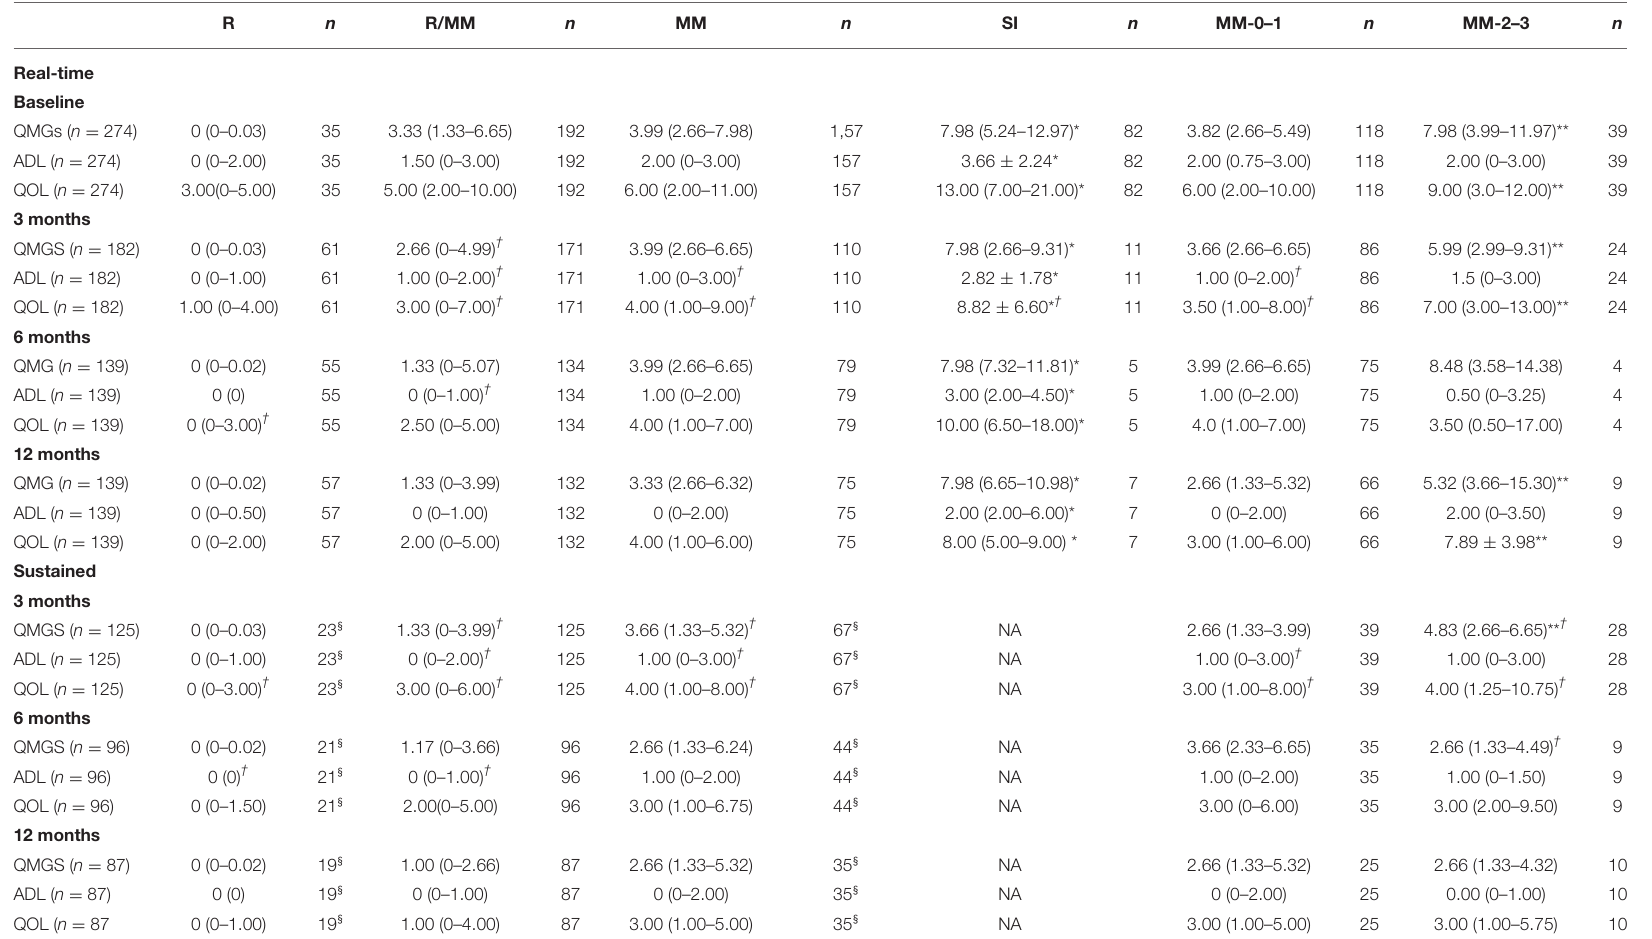
TABLE 7 | The scores of QMG, MG- ADL, and QOL in patients belonging to each PIS category at each follow-up in the whole cohort (real-time or